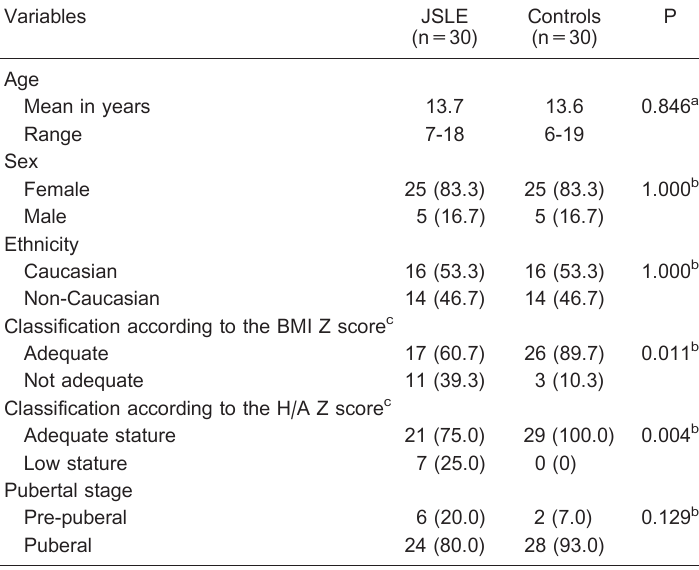
Table 1. Characteristics of demographics, nutritional status and pubertal stage of patients (n=30) with juvenile systemic lupus erythematosus (JSLE) and controls.